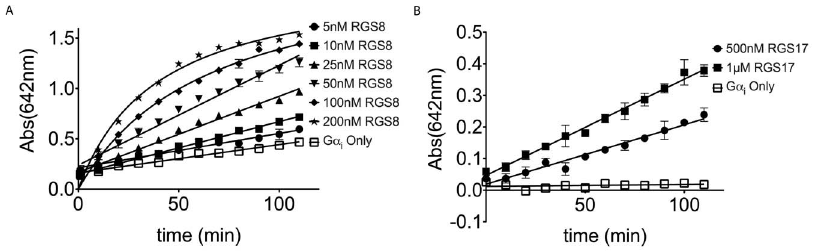
Figure 3. Characterization of Malachite Green Assay with RGS8 and RGS17. (A) Increasing concentrations of RGS8 from 5 nM final to 200 nM final, represented as closed symbols, show signal about equal to 2 6 the concentration of RGS4, similar to as shown in literature [4]. For comparison, 5 m M final G a i was included, represented by open symbols. GTP only (150 m M final) control wells were used for background subtraction. (B) Using a G a i double mutant protein with an accelerated K off for GDP exchange and decrease K cat for GTPase activity we can monitor the effect of RGS17 on the intrinsic GTPase activity of the G a i subunit. GTP only (300 m M final) control wells were used for background subtraction.